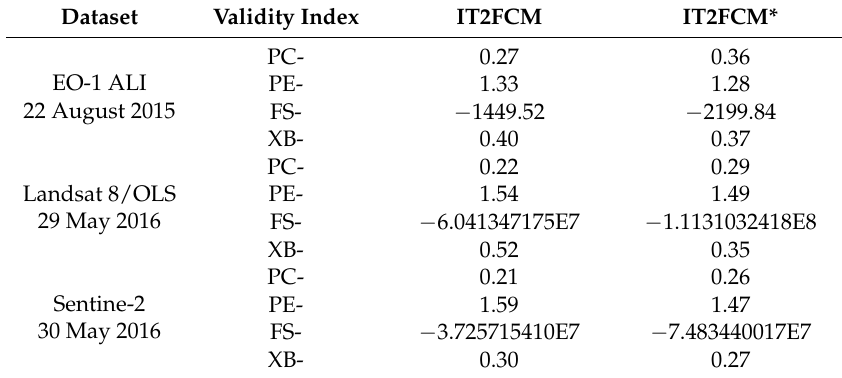
Table 2. Comparison of validity indexes with from different satellite remote sensing